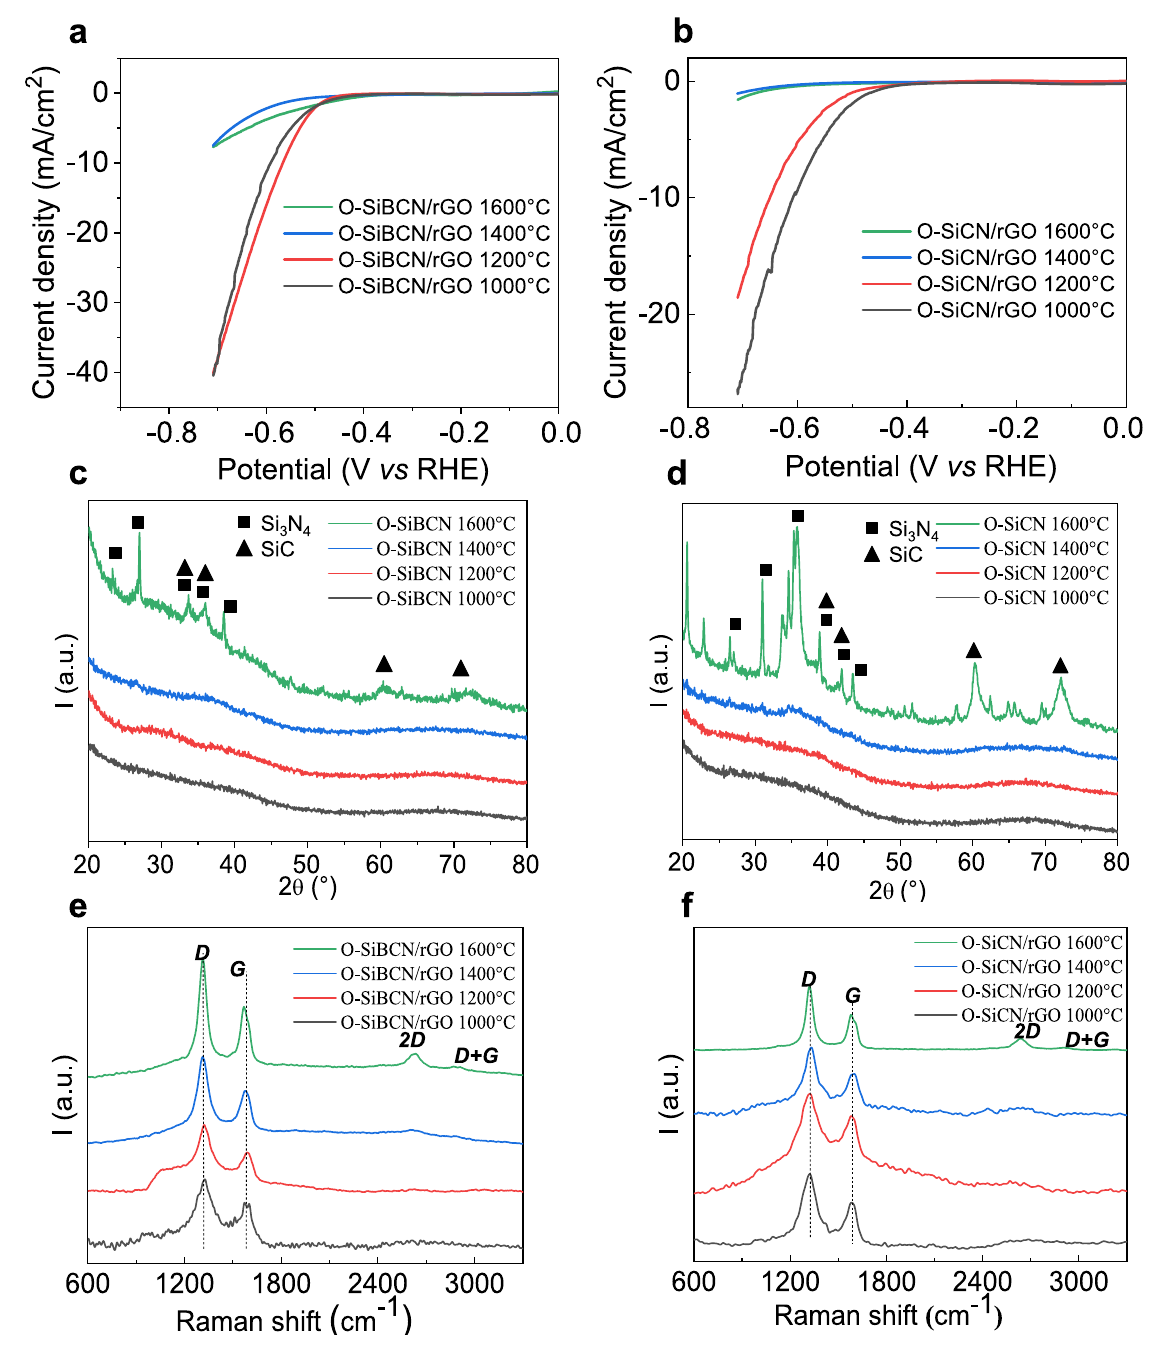
Figure 6. Polarization curves of O-SiBCN/rGO ( a ) and O-SiCN/rGO ( b ) composites at different temperatures. ( c , d ) X-Ray diffractograms of O-SiBCN ceramics and O-SiCN ceramics at different temperatures. ( e , f ) Corresponding Raman spectra of O-SiBCN/rGO and O-SiCN